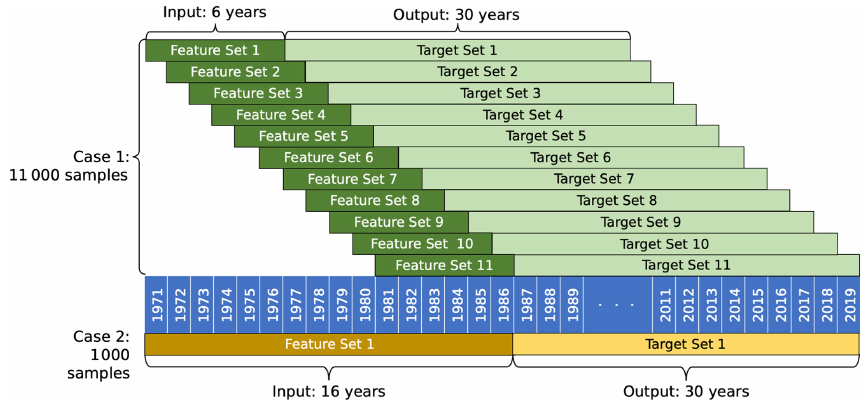
Figure 2. The change in sample size ( K ) for two different input year lengths ( T i ) for Test